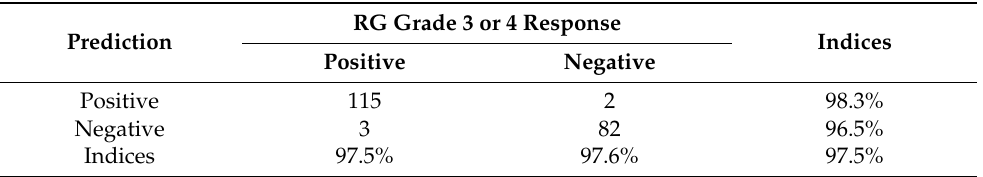
Table 2. Classification indices for tumor regression grade 3 or 4 responses in all five sets of the training cohort, comparing patients with and without favorable responses.